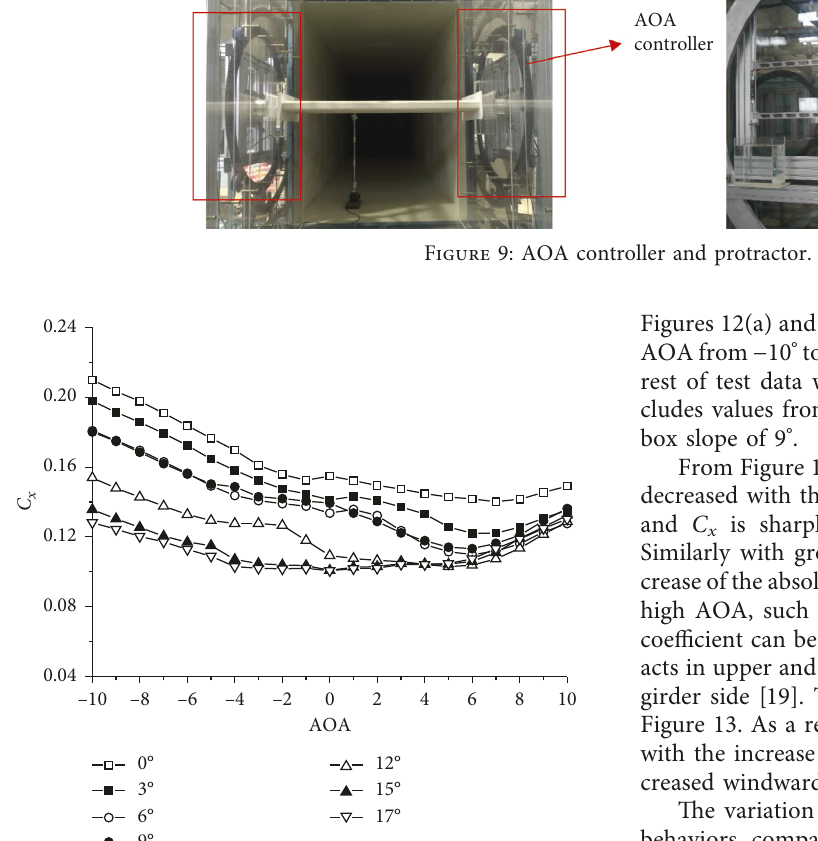
Figure 10: C x vs. AOA for various box slope angles.